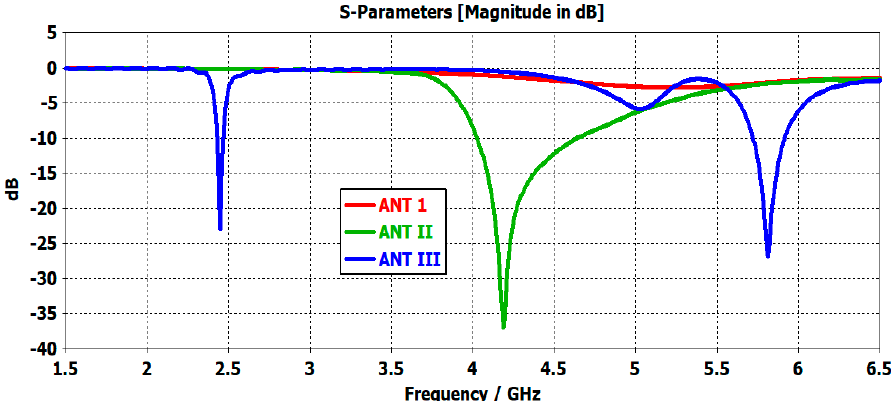
Figure 4. S 11 of proposed designs of the antennas (ANT I-III) in Figure 3.